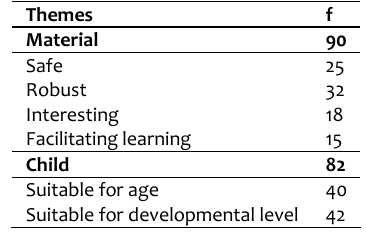
Table 2. Things to take into consideration by the preschool teachers during preparation of the science and mathematics